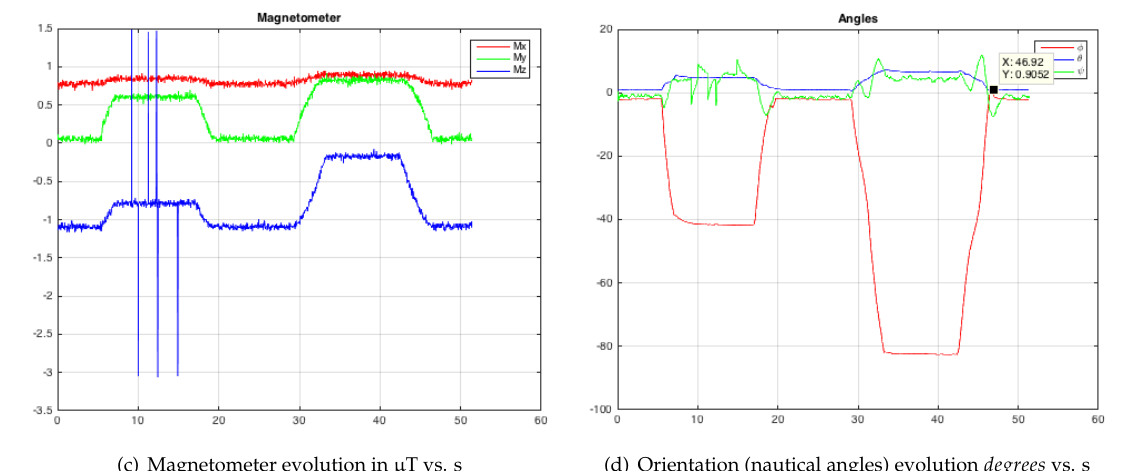
Figure 6. Test 2—Modifying the roll angle ( φ